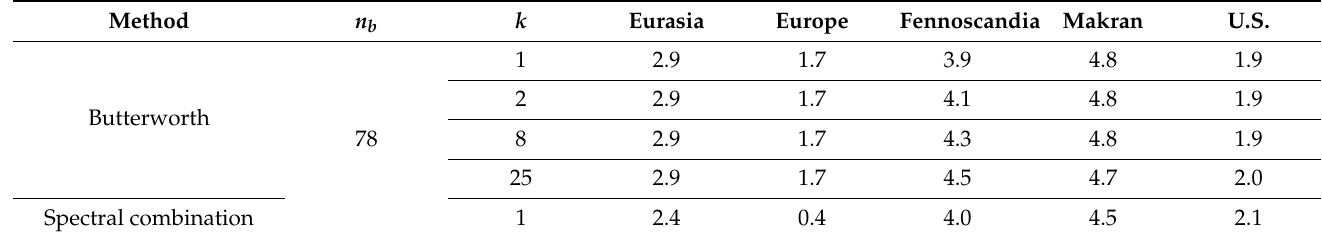
Table 1. RMS of the Moho depth differences between the results obtained by applying the Butterworth and spectral combination techniques and the continental and regional Moho depth models for